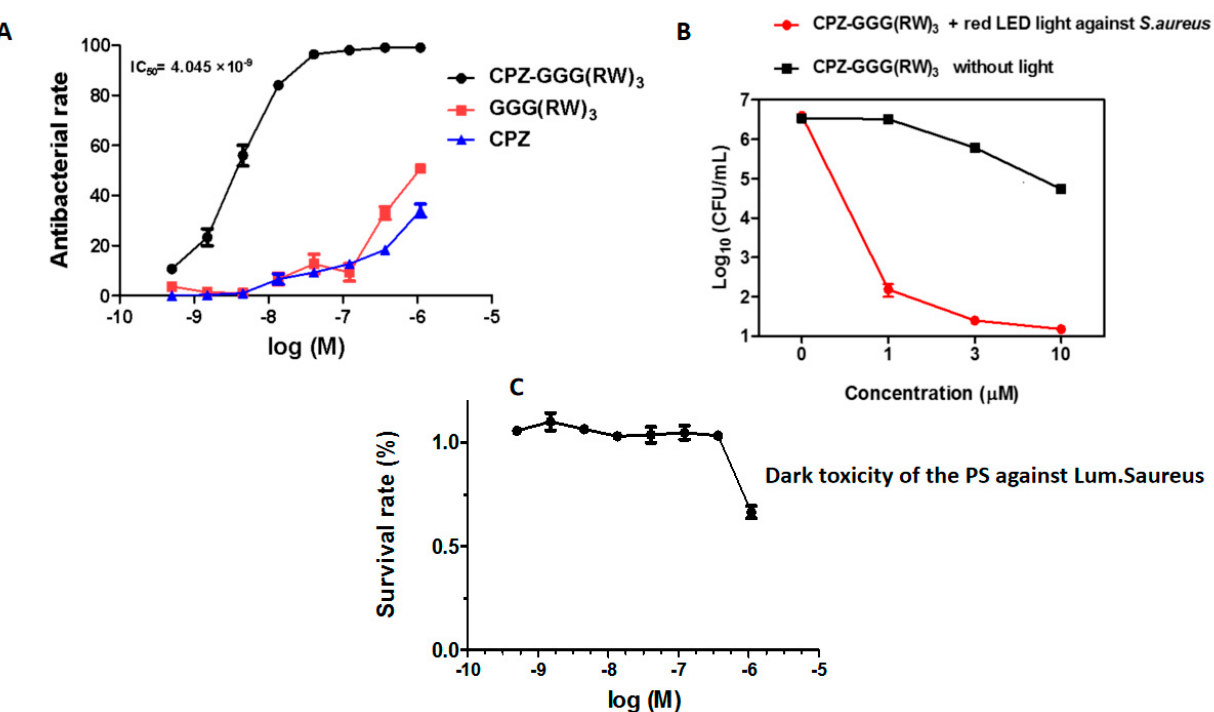
Figure 4. Phototoxicity of CPZ-GGG(RW)3 and antibacterial efficacy of GGG(RW)3 against the luminescent S. aureus ( A ) under light illumination using red LED light illumination (22.5 J/cm 2 ). Photodynamic effects of CPZ-GGG(RW)3 against S. aureus ( B ) were also measured using the colony counting method under light illumination from a red LED light (22.5 J/cm 2 ), as well as the dark toxicity of CPZ-GGG(RW)3 against the luminescent S. aureus under the same experimental condition ( C ).